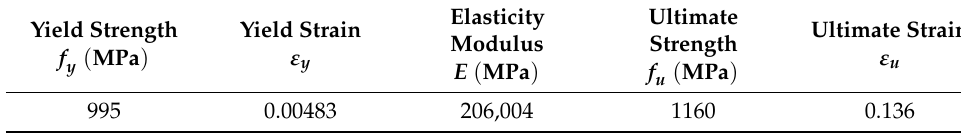
Table 7. Mechanical properties of high-strength bolt 10.9